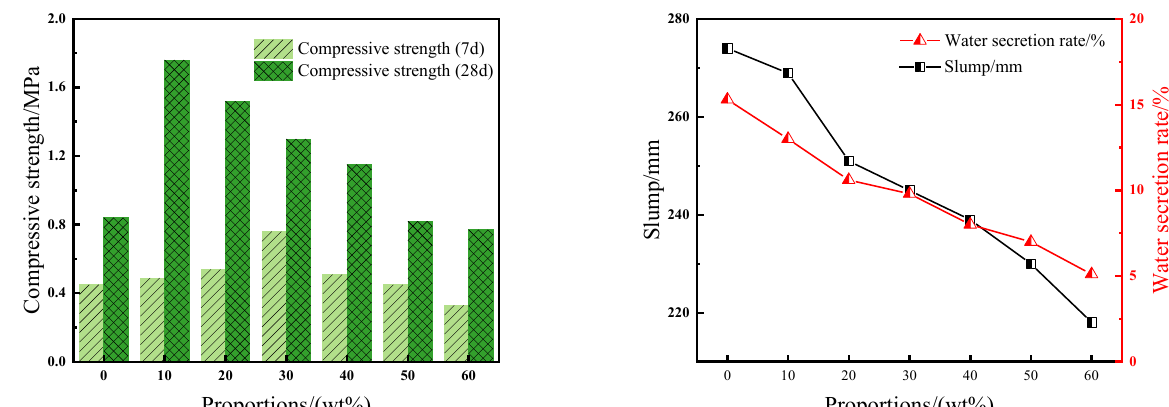
( b ) Effect of proportions on slump and water secretion Figure 4. Effect of proportions on CFTFM performance. Figure 4. Effect of proportions on CFTFM